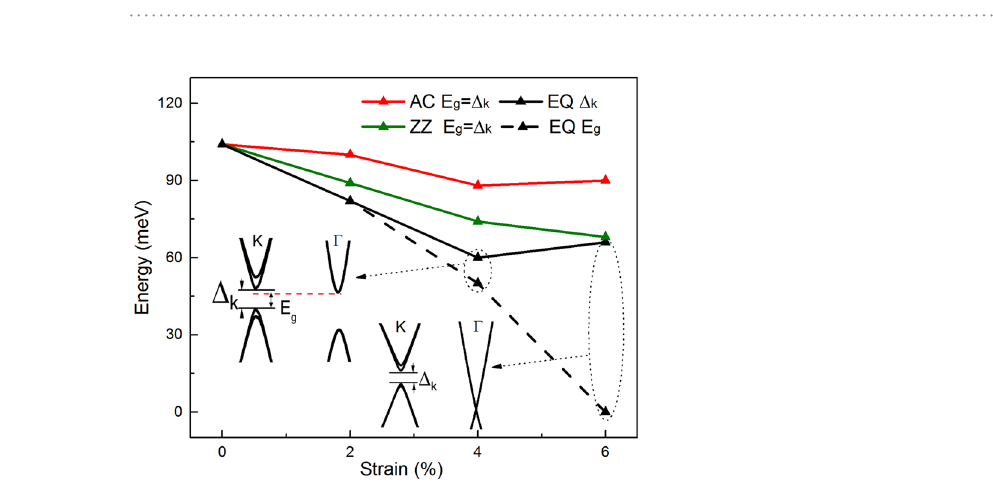
Figure 2. Band structure for unstrained ( a ) stanene and ( b ) stanane calculated at the LDA (red dotted), LDA + SOC (red solid), and GW + SOC (black solid) levels.